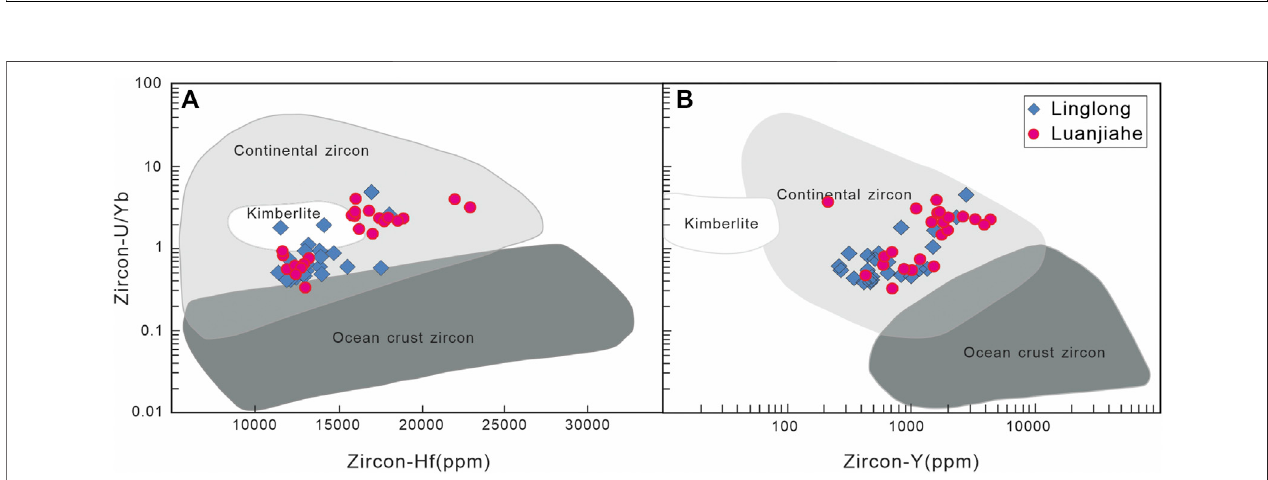
FIGURE 8 | Zircon Hf vs U/Yb (A) and Y vs U/Yb (B) diagrams for the Linglong and Luanjiahe granites in the Jiaobei terrane. The fi elds of continental and oceanic crust zircon and kimberlite are after Grimes et al. (2007).